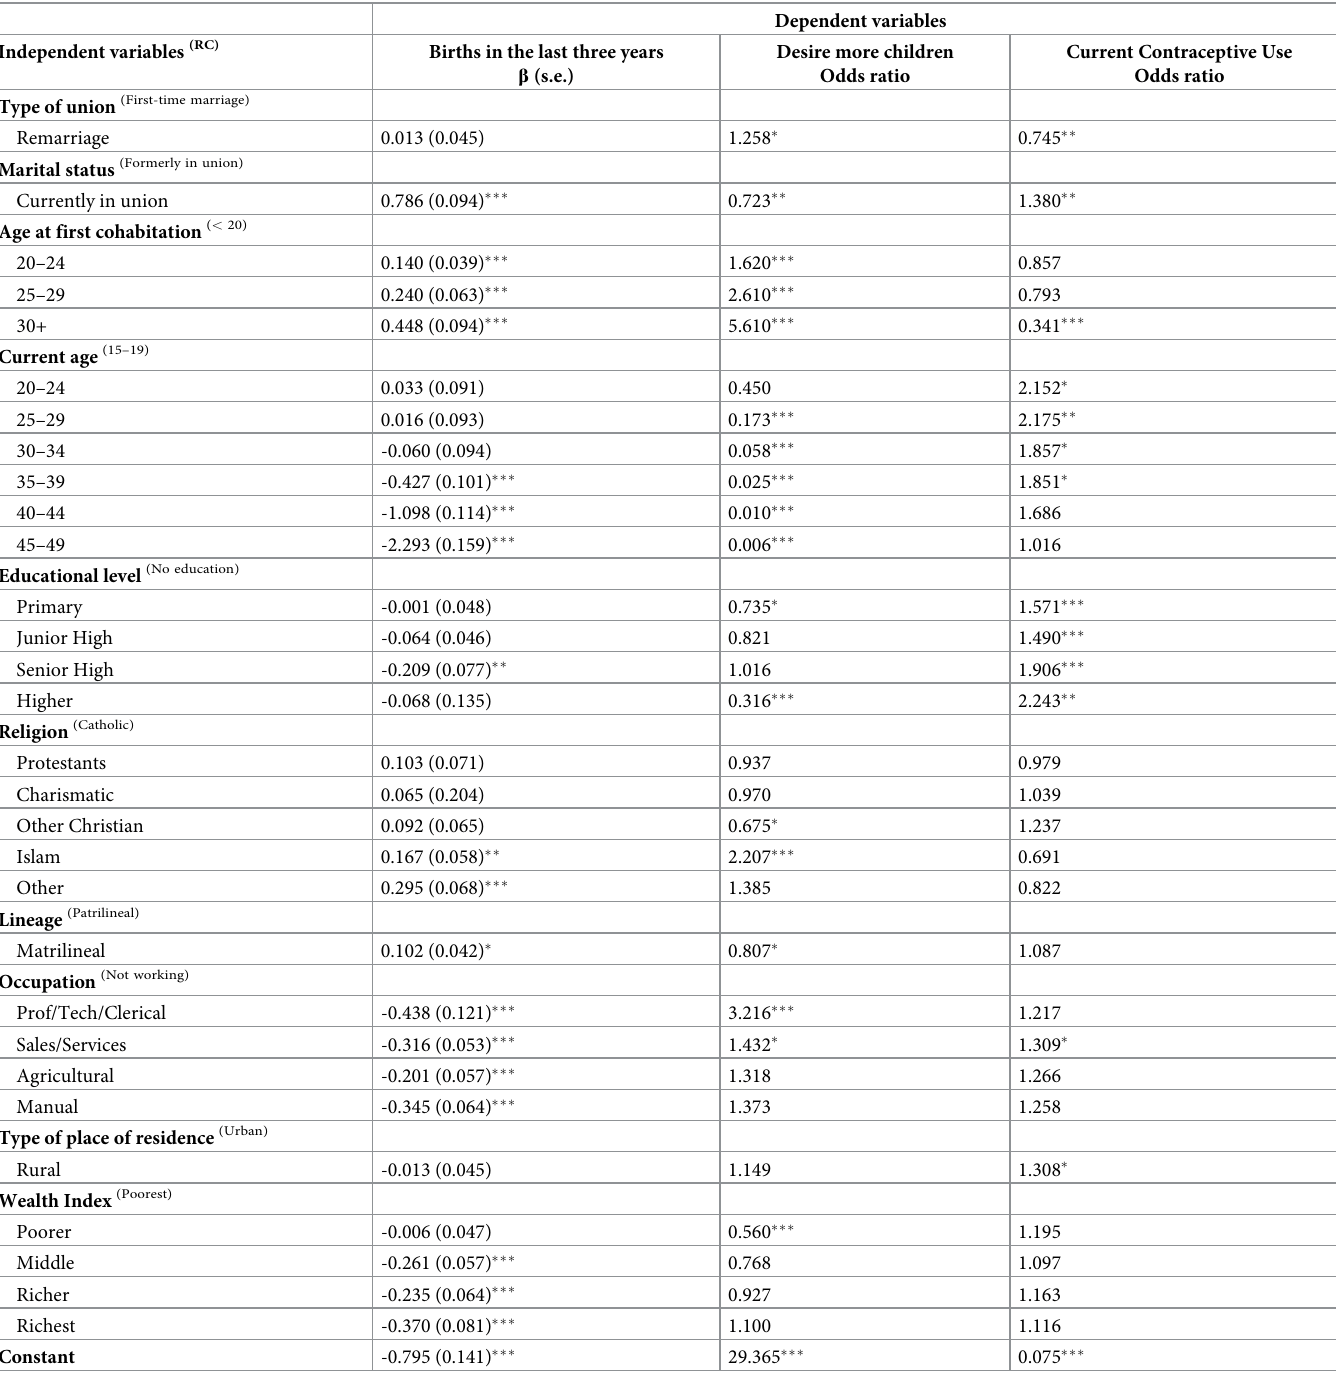
Table 4. Multivariate regression results showing predictors of births in the last three years, desire for more children and current contraceptive